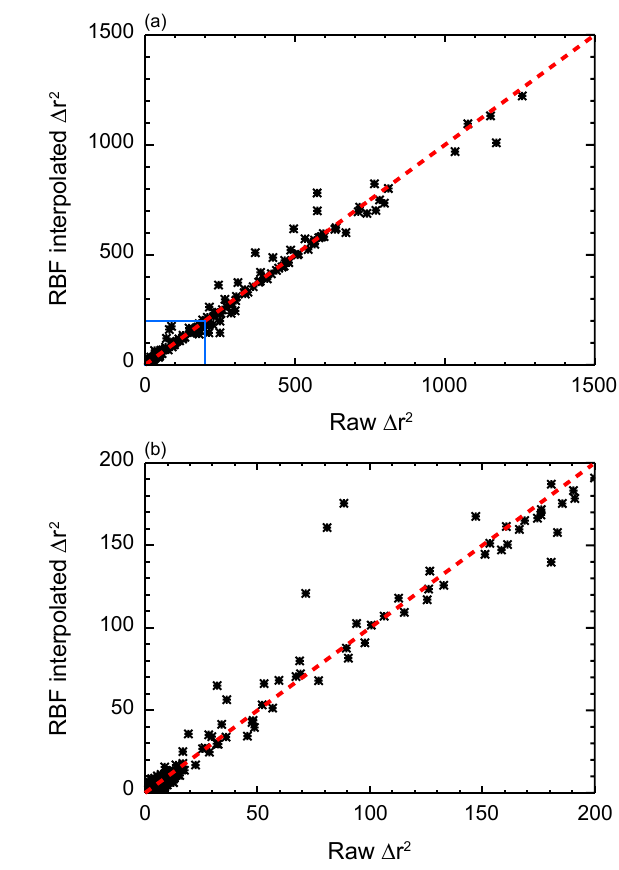
Figure 5. Comparison of (cid:49)r 2 values calculated from out-of- sample model runs and those calculated using the RBF interpola- tion method. (a) All 300 runs. (b) All runs with (cid:49)r 2 less than 200. The one-to-one line is plotted for reference (red, dashed line).